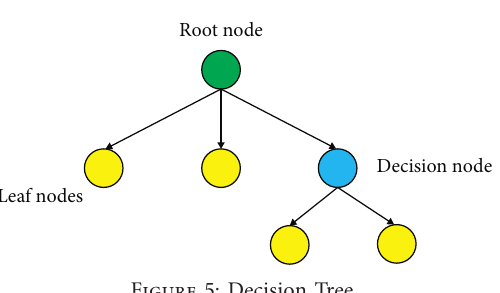
Figure 5: Decision